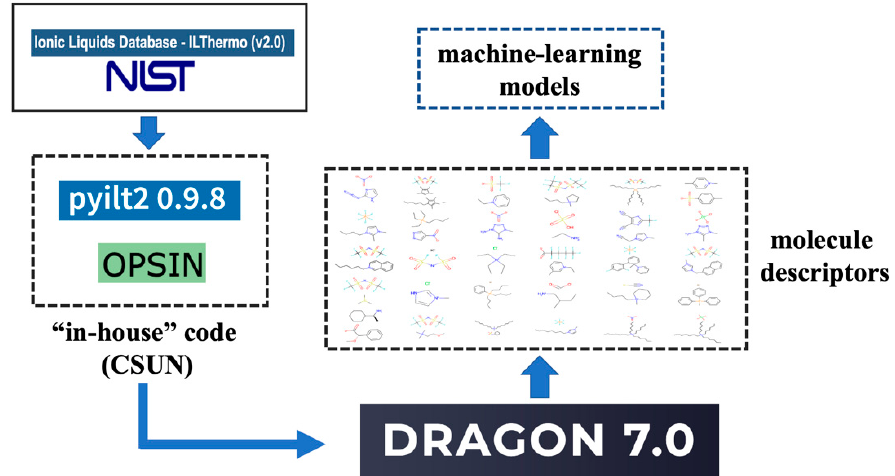
Figure 1. The workflow of basic methodology that adopted in this work to predict melting point ( T m ) of various ionic liquids based on machine-learning (ML) model (i.e., deep-learning